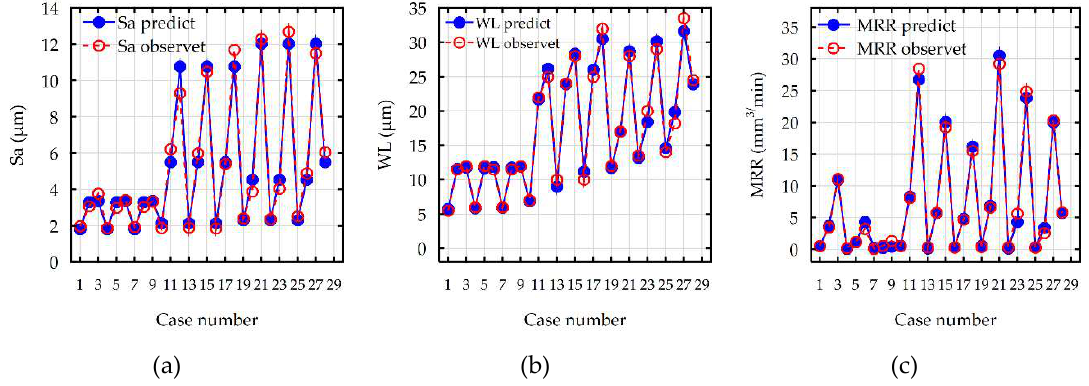
Figure 10. The comparison between the results of experimental studies to the values calculated based on the developed models for ( a ) surface roughness ( Sa ); ( b ) maximal thickness of white layer (WL); on the developed models for ( a ) surface roughness ( Sa) ; ( b ) maximal thickness of white layer (WL ) ; ( c ) material removal rate ( c ) material removal rate (MRR ).